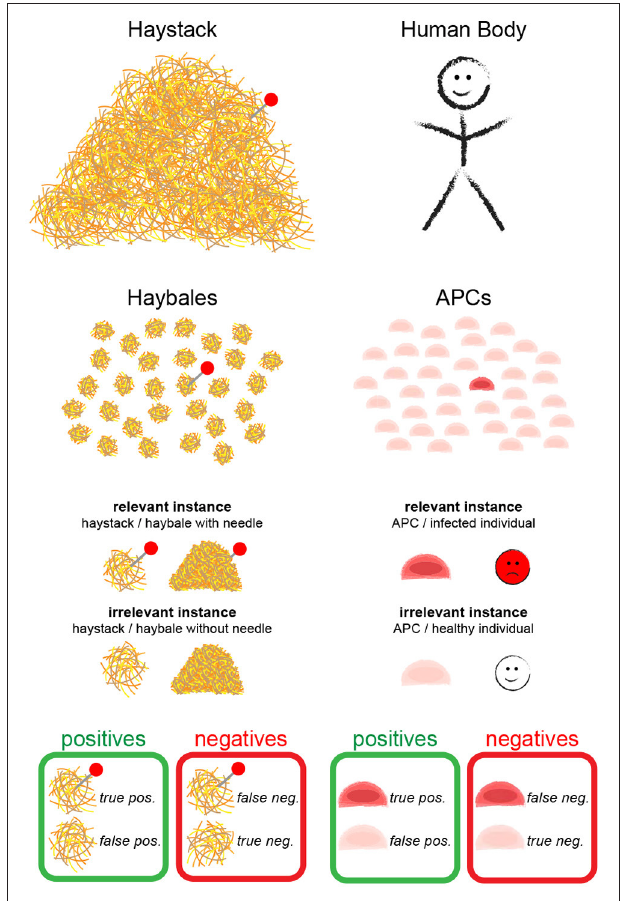
FIGURE 1 | The needle in the haystack problem. Terms and statistical concepts referred to in the text are shown for the hypothetical search of the needle in the haystack (Left) and for the search of a T cell for cognate antigen on APCs (Right) .